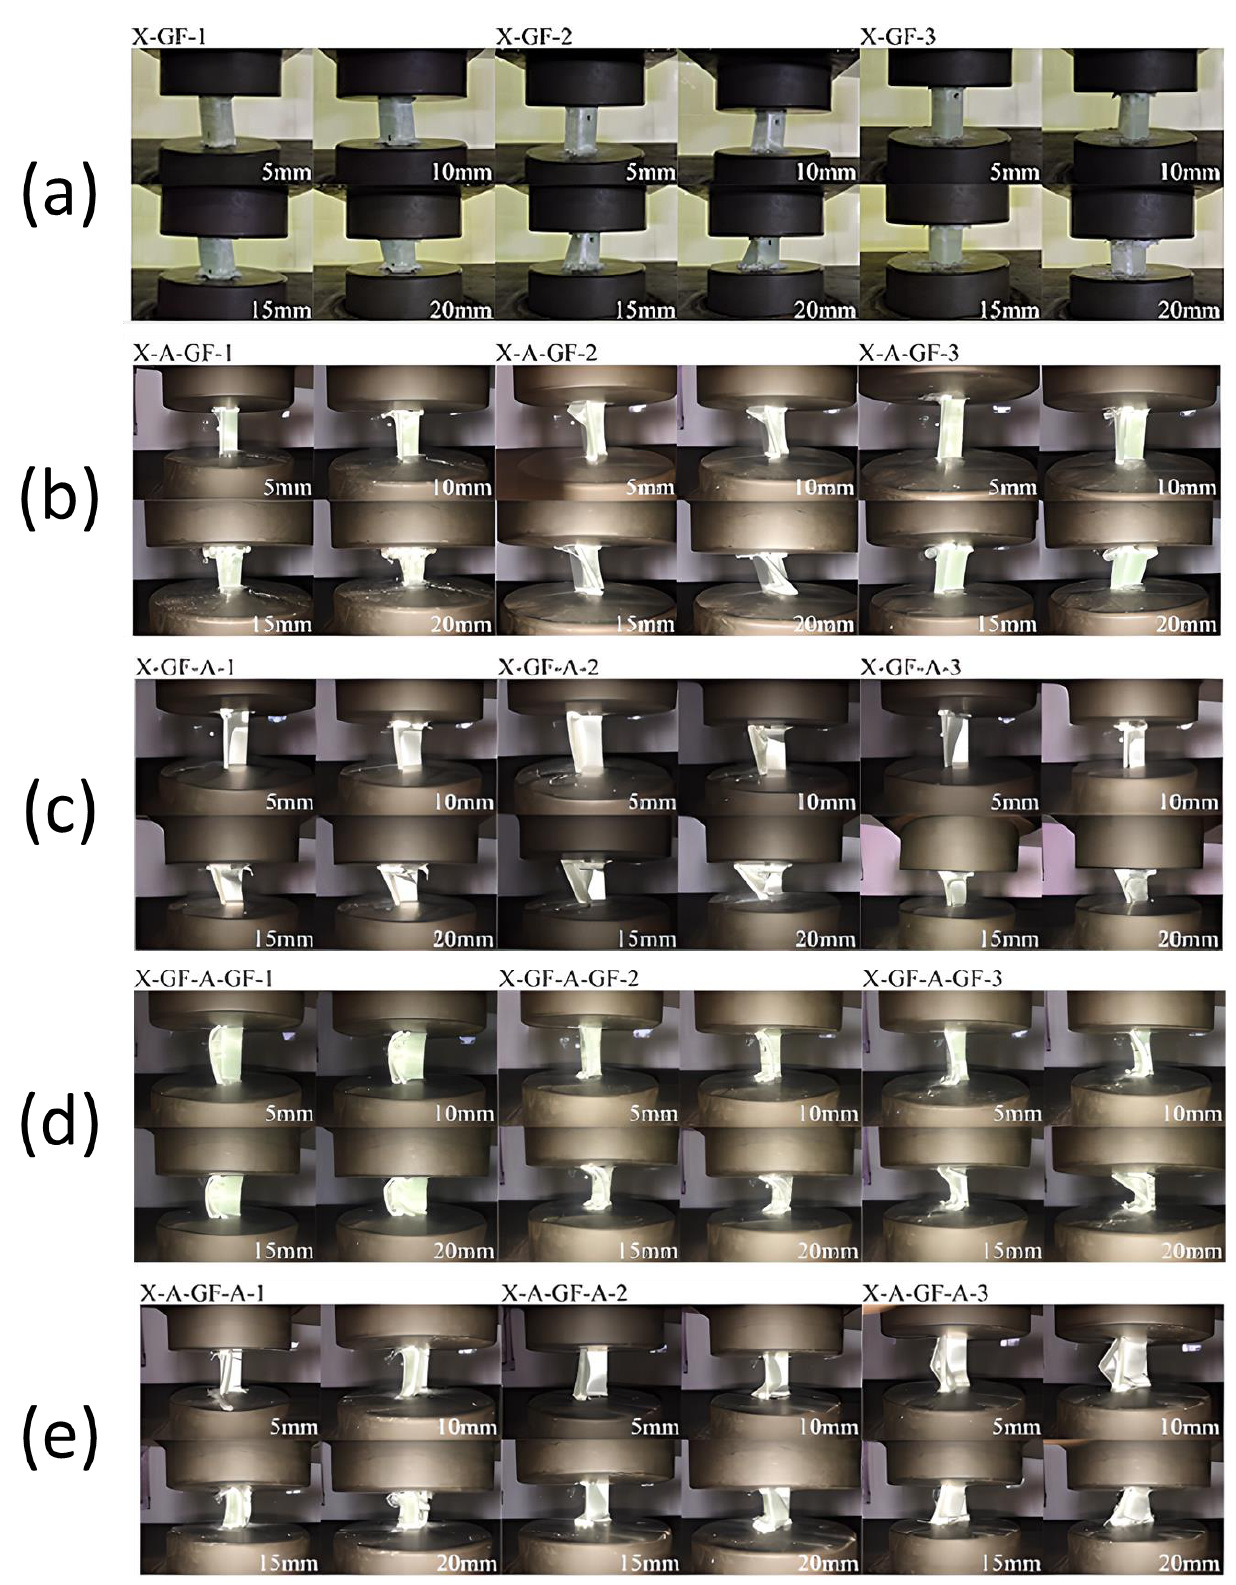
Figure 10. Axial deformation history of ( a ) net GFRP, ( b ) AGF, ( c ) GFA, ( d ) GFAGF, ( e ) AGFA.